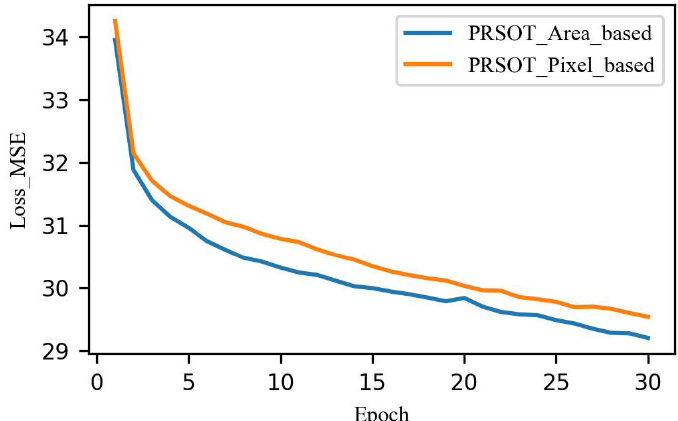
Figure 5. The MSE loss variation curves of PRSOT_Area_based model and PRSOT_Pixel_based model in the training